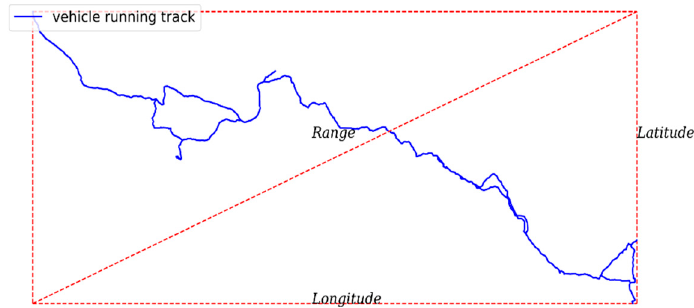
Figure 4. A sample of a trajectory of a driver and the rectangle used to calculate the range.